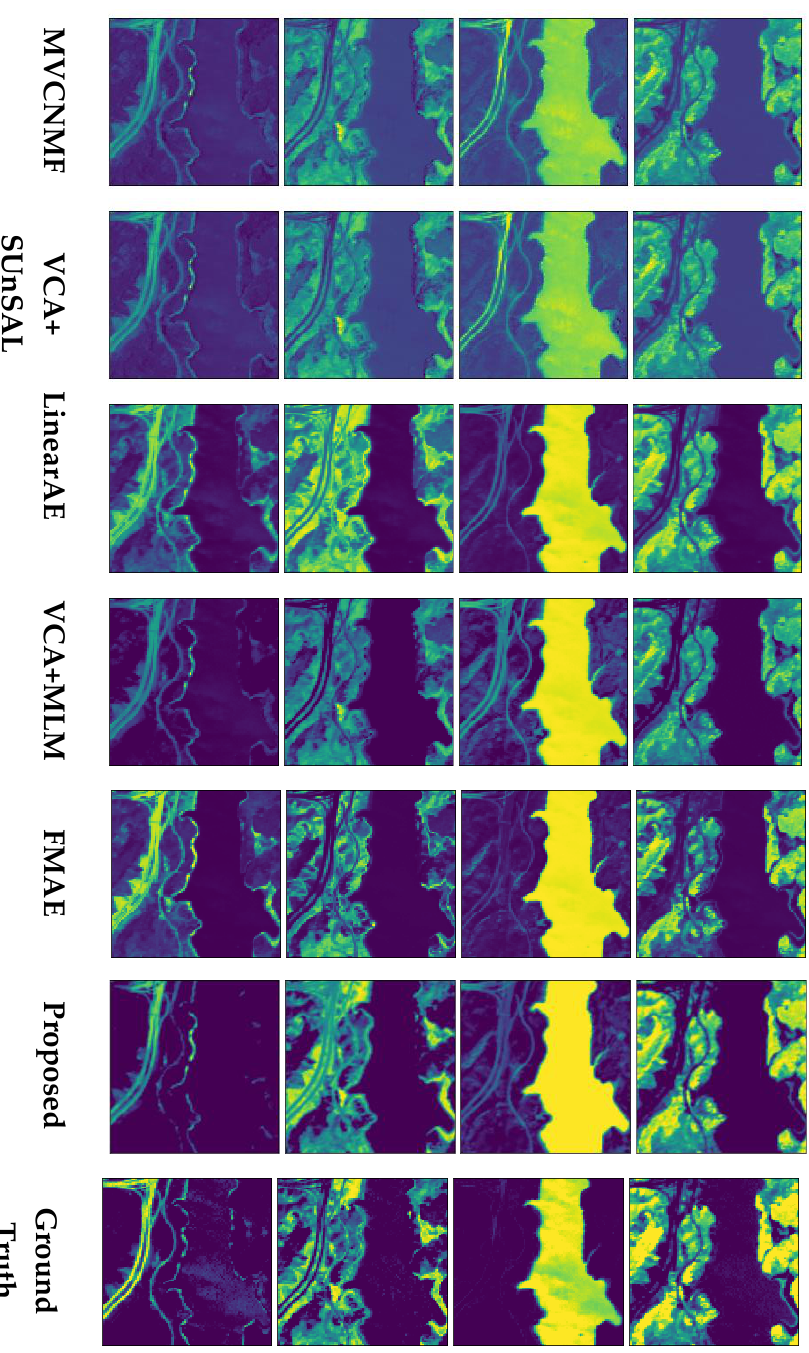
Figure 9. Estimated abundance maps for Jasper Ridge. From left to right for different endmembers: